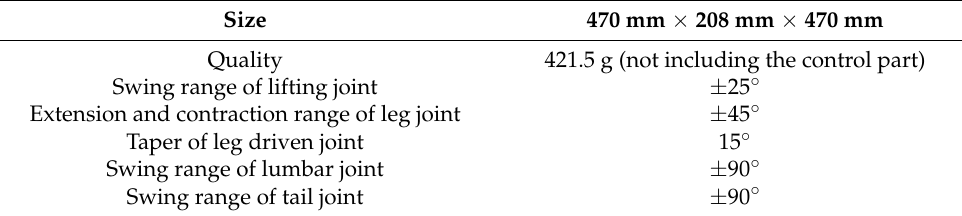
Table 1. Main parameters of the gecko-like